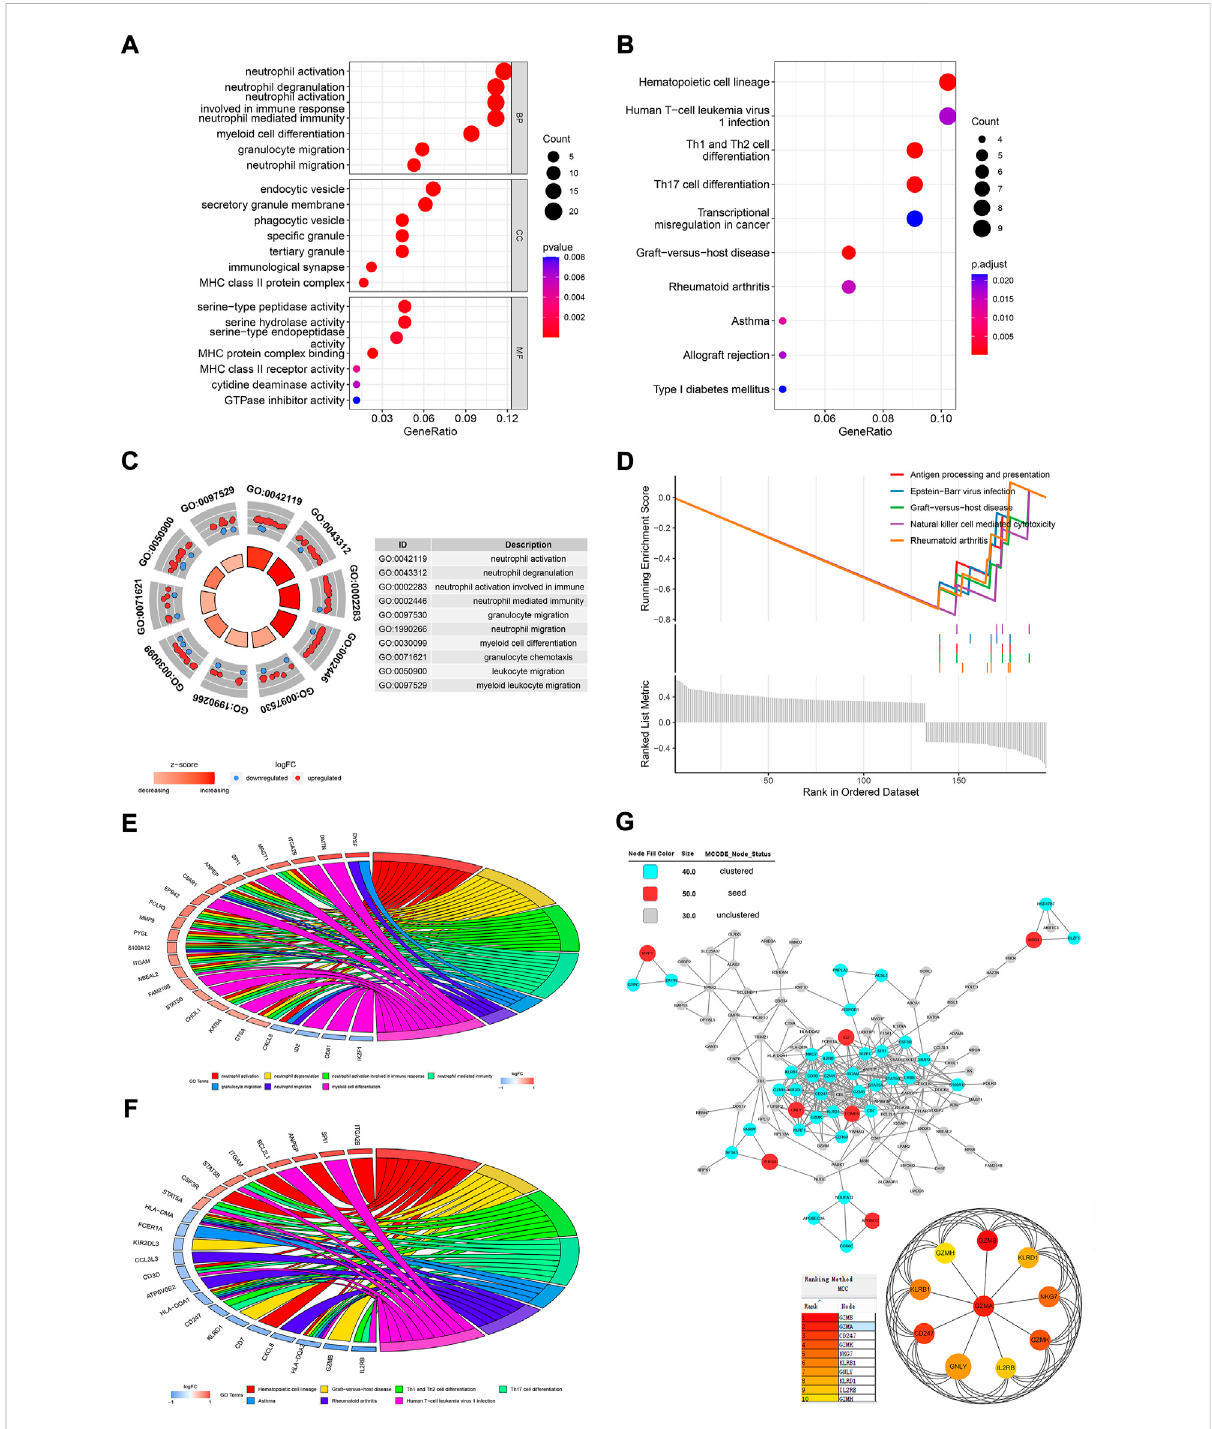
FIGURE 4 Functional analysis ofthe DEGs between normal people and ASpatients. Dot plots for GO (A) and KEGG (B) analyses of DEGs. (C) Circle plotfor BP clustering of the DEGs. (D) GSEA analysis for the DEGs. (E) Chord plot for the top seven clustered GO terms. (F) Chord plot for the top seven clustered KEGG pathways. (G) PPI network analysis for